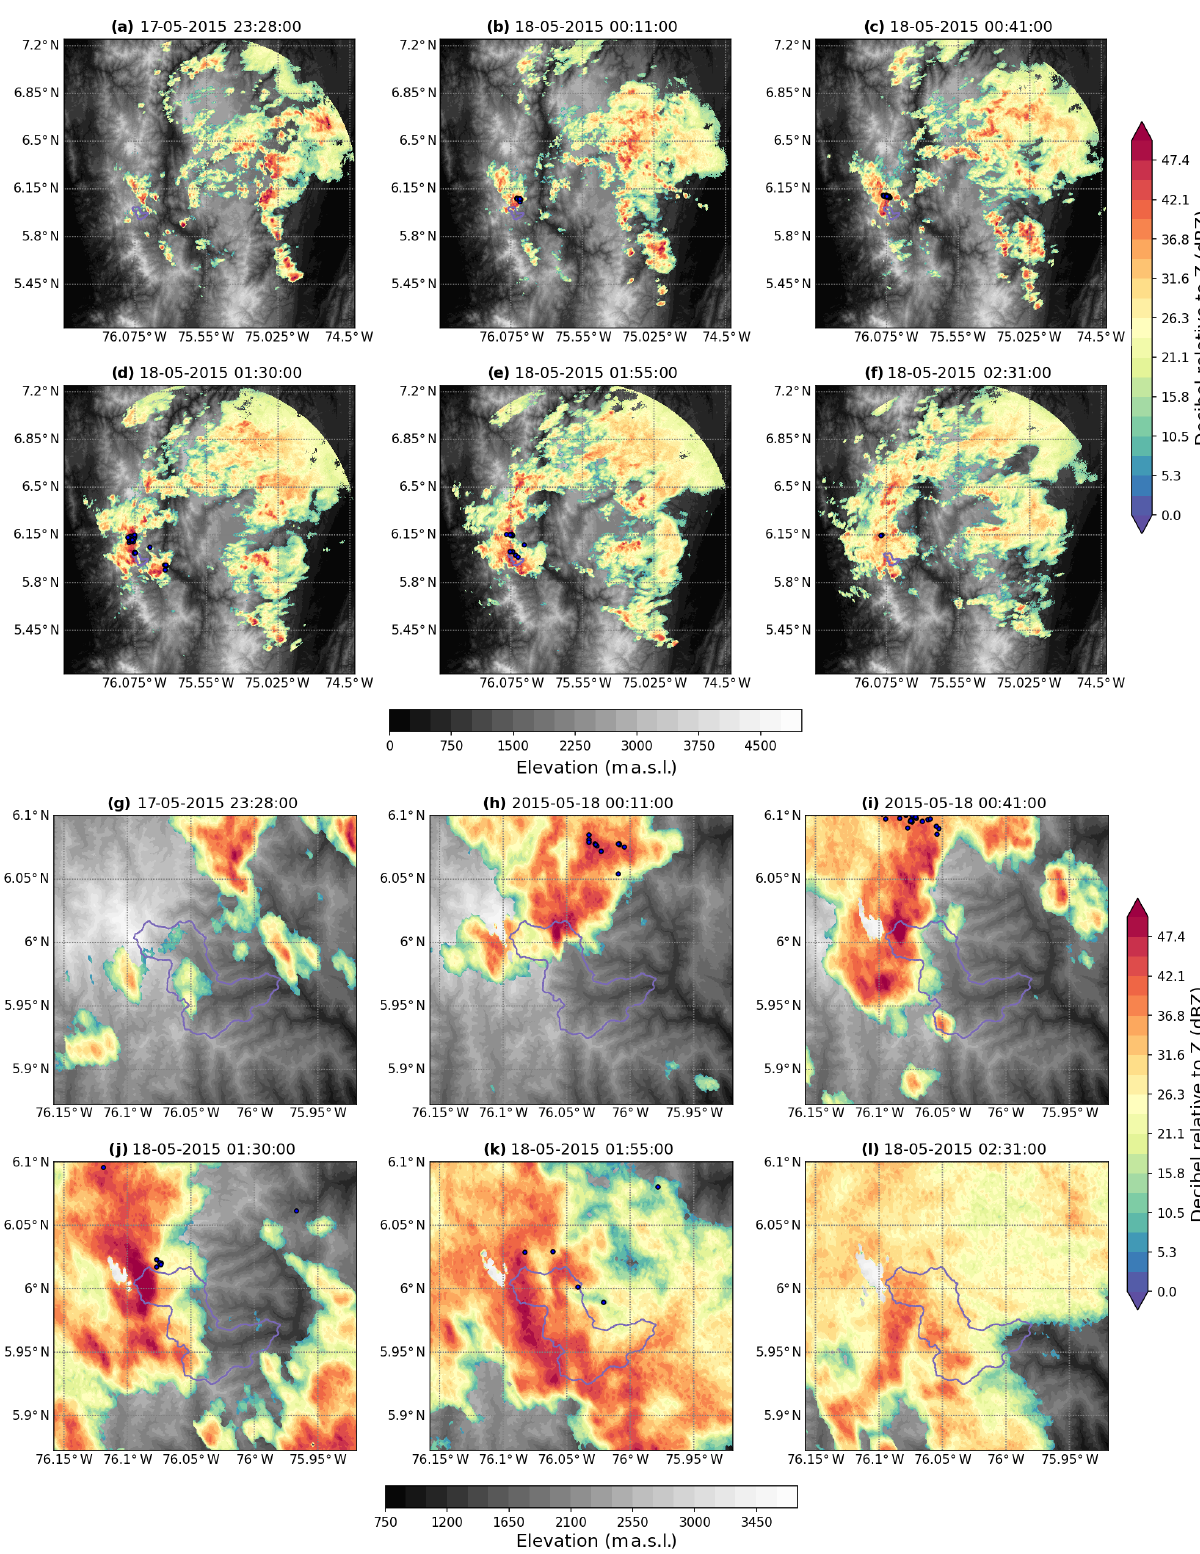
Figure 13. Similar to Fig. 12 for the flash-flood-triggering event (period